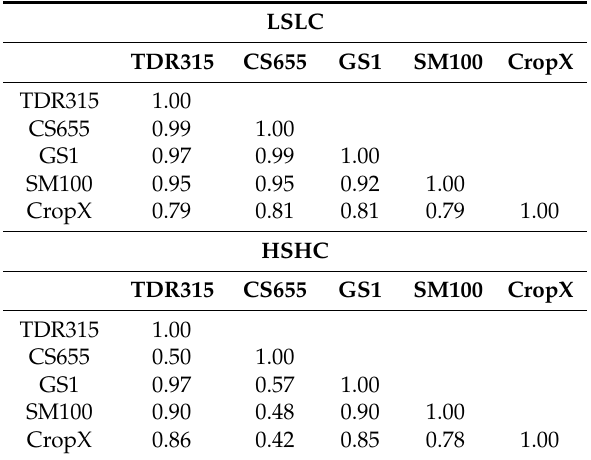
Table 5. Pearson correlation coefficients among installed sensors at study